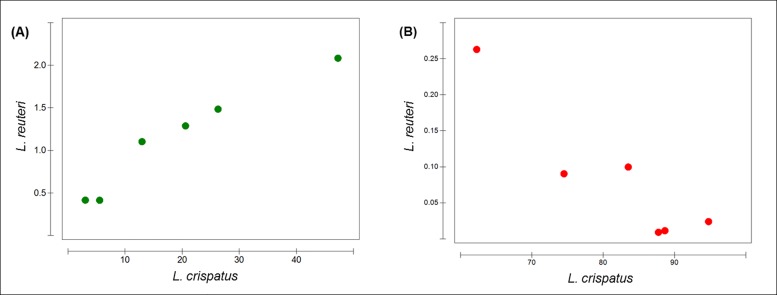
Draftsman plot showing the relative abundance (%) of one species-of-interest against another.(A) Positive correlation in crop and (B) negative correlation in jejunum between L. crispatus and L. reuteri in all six dietary treatments.